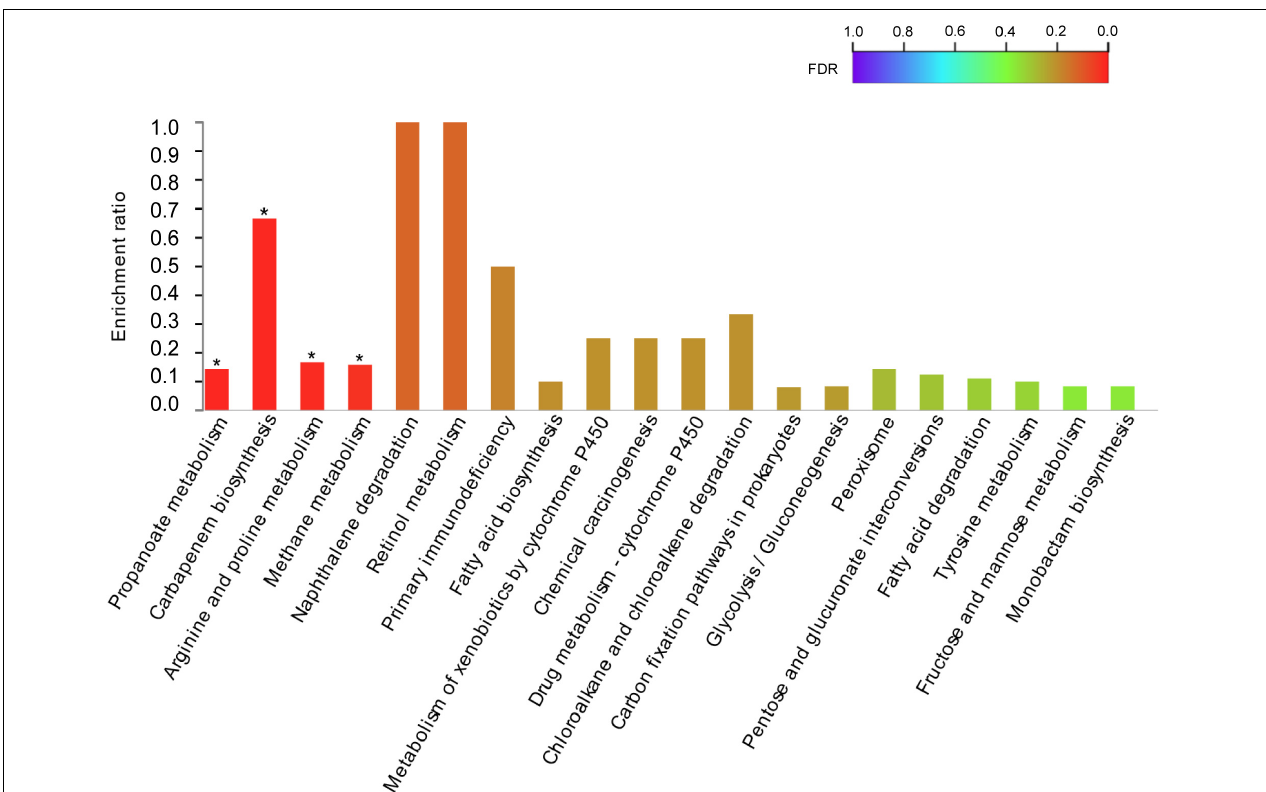
FIGURE 6 | KEGG pathway enrichment analysis of DEGs between CTR and FUR exposure biofilms. * p < 0.05. Control (CTR), P. marina ECSMB14103 biofilm prepared on a sterile glass slide without adding FUR; FUR, 10 4 M FUR-treated P. marina ECSMB14103